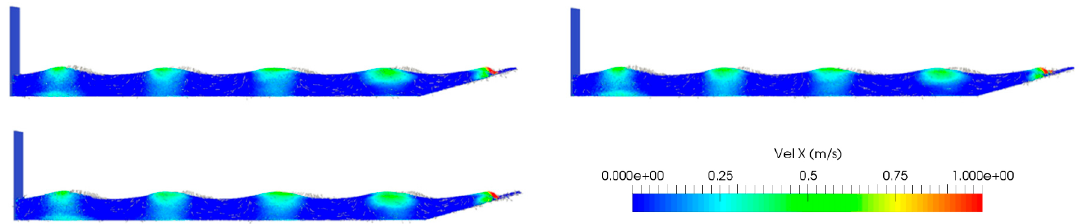
Figure 20. Comparison of wave elevation of the experiment, 2-D and 3-D SPH for A = 50.5 mm and T = 1.15 s.